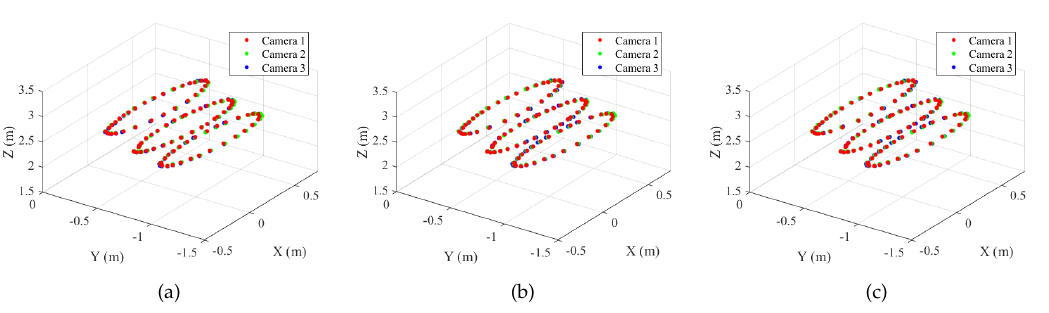
Figure 14. Aligned sphere centers (static set, N = 95). ( a ) Proposed method (pairwise). ( b ) Proposed method (Bundle Adjustment (BA)). ( c ) Su et al. [20]. Refer to the text for more detail. Best viewed in color.